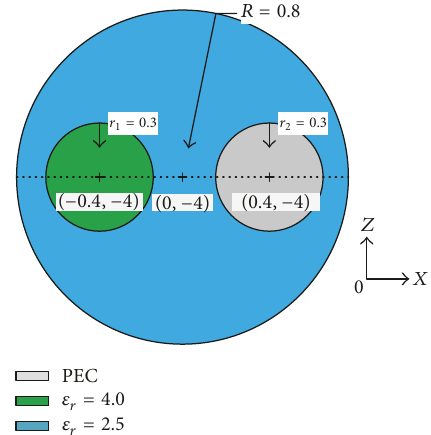
Figure 4: Cross-section of an inhomogeneous